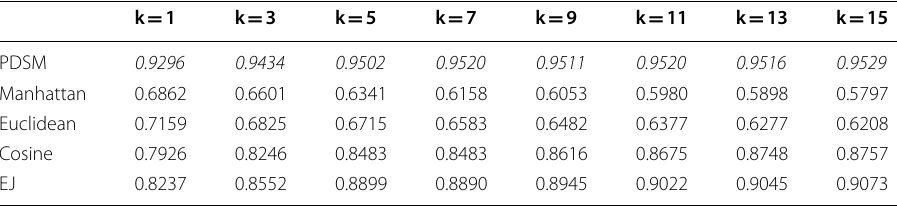
Maximum accuracy is